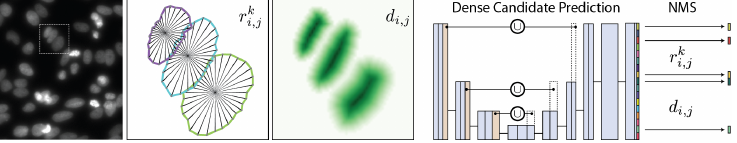
Figure 27. Star-convex polygons ( left to right ) parameterized by the radial distances r k object probabilities d i , j , using U-Net architecture for density